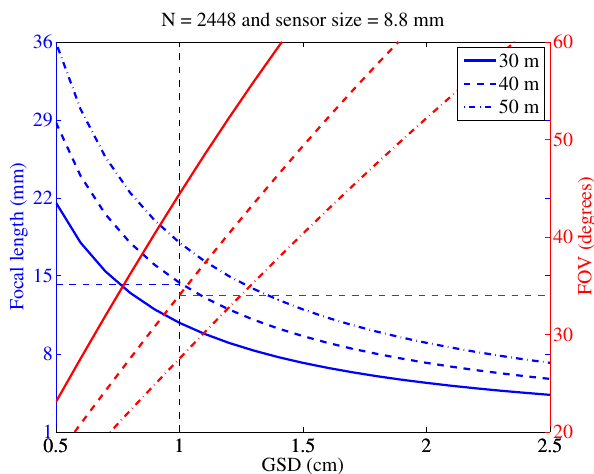
Figure 2: Focal length and Field of View (FoV) as a function of the Ground Sampling Distance (GSD) in relation to the flying height above